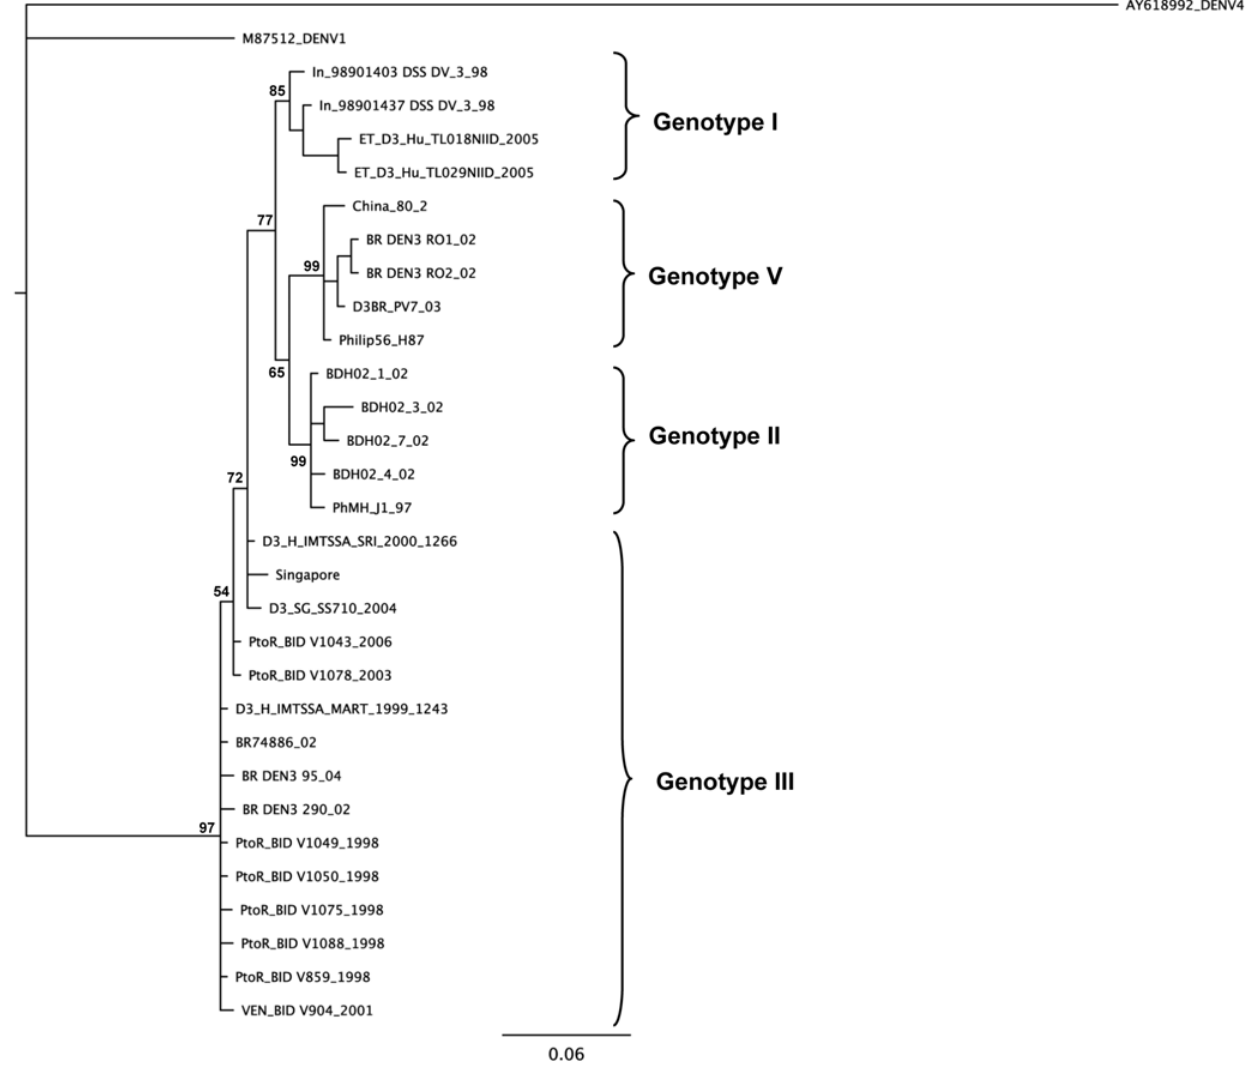
Figure 4. Bayesian phylogenetic trees derived from 31 global samples of DENV-3 based on the 3 9 UTR sequences inferred with MrBayes program. The posterior probabilities expressed in percent are indicated key nodes. The DENV-1 (M87512) and DENV4 (AY618992) strains were used as outgroup. Horizontal branch lengths are drawn to scale. Aligned sequences were analyzed in the MrModeltest 2.3 program to identify the best fit-model of nucleotide substitution for Bayesian phylogenetic reconstruction. The nucleotide substitution model used was under a General Time Reversible model of nucleotide substitution with a proportion of invariable sites (I=0.6264) (GTR + I), using Akaike’s Information Criterion (AIC). Five runs of 4 chains each (one cold and tree heated, temperature=0.20) were run for 1.5 6 10 6 generations, with a burn-in of 6000